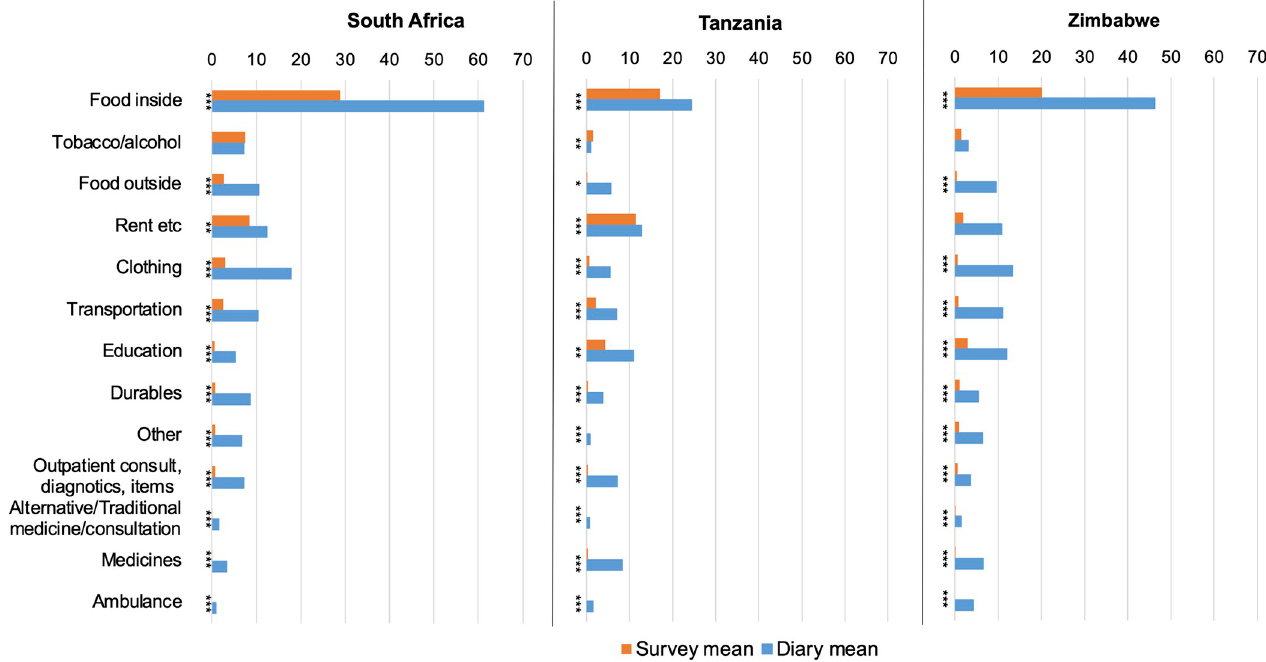
Fig 2. Mean monthly household per capita expenditure by category via PURE survey vs. pictorial diary, 2014 USD. 2-sided paired t-test for the difference in means: * p < 0.05, ** p < 0.01, *** p < 0.001.